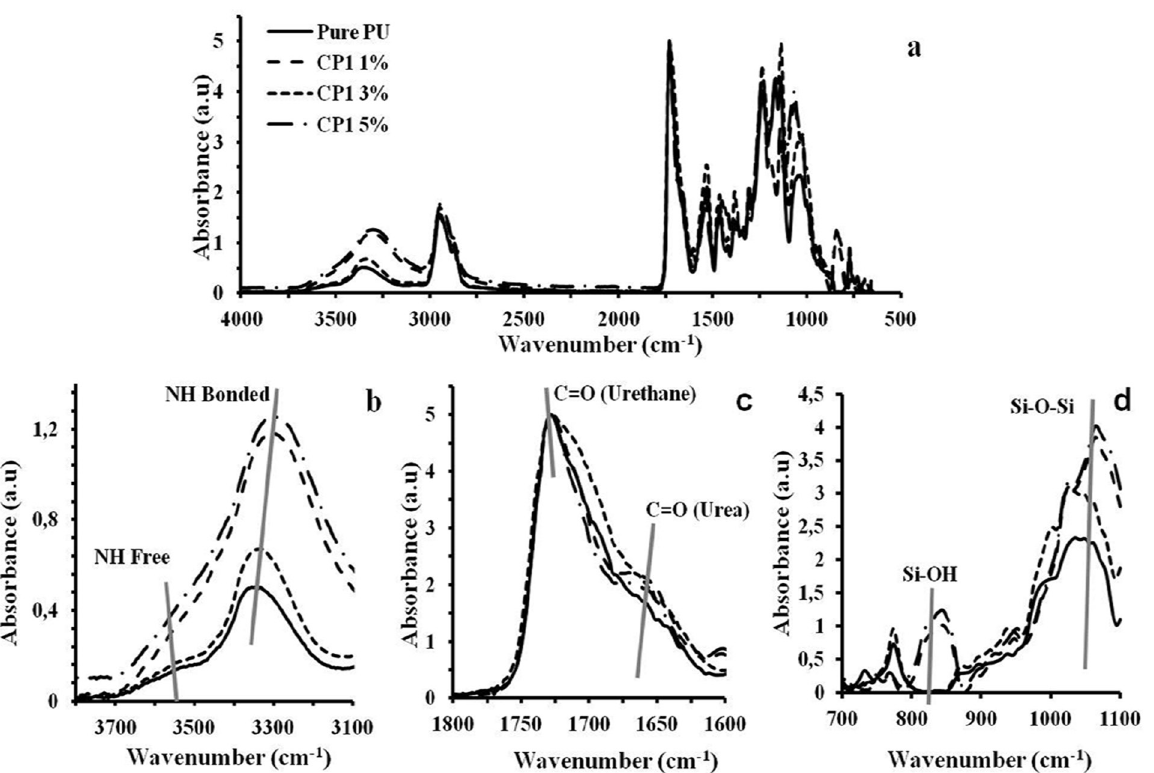
Figure 1 - FTIR spectra of the pure PU and CP1 composites ( a ); zoom in the region of Nh band ( b ); zoom in the of C=O band and ( c ) zoom in the region of Si-Oh,